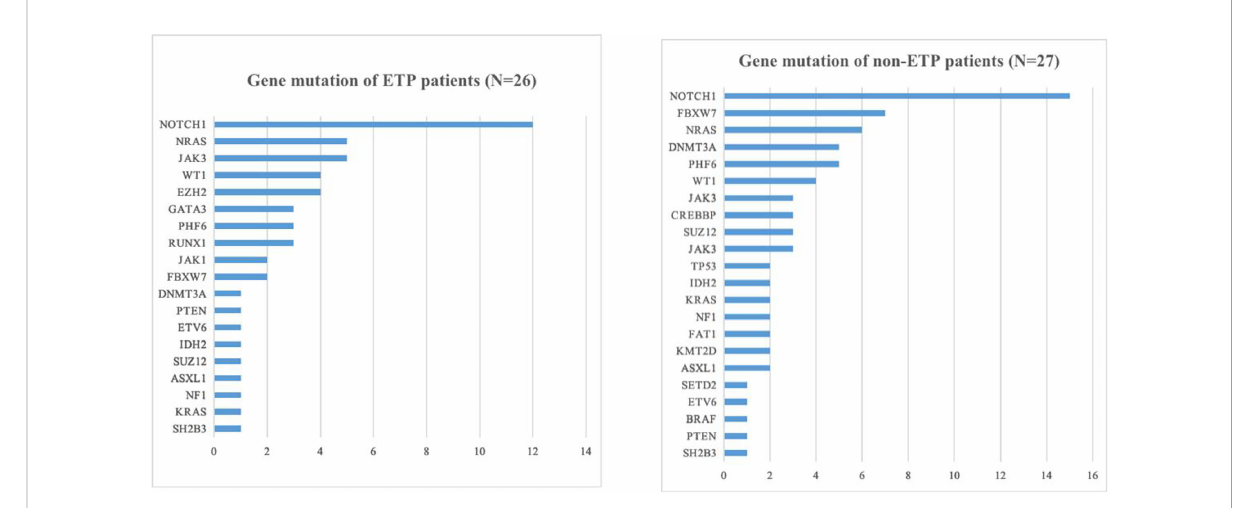
FIGURE 1 Gene mutation of early T-cell precursor (ETP) and non-ETP